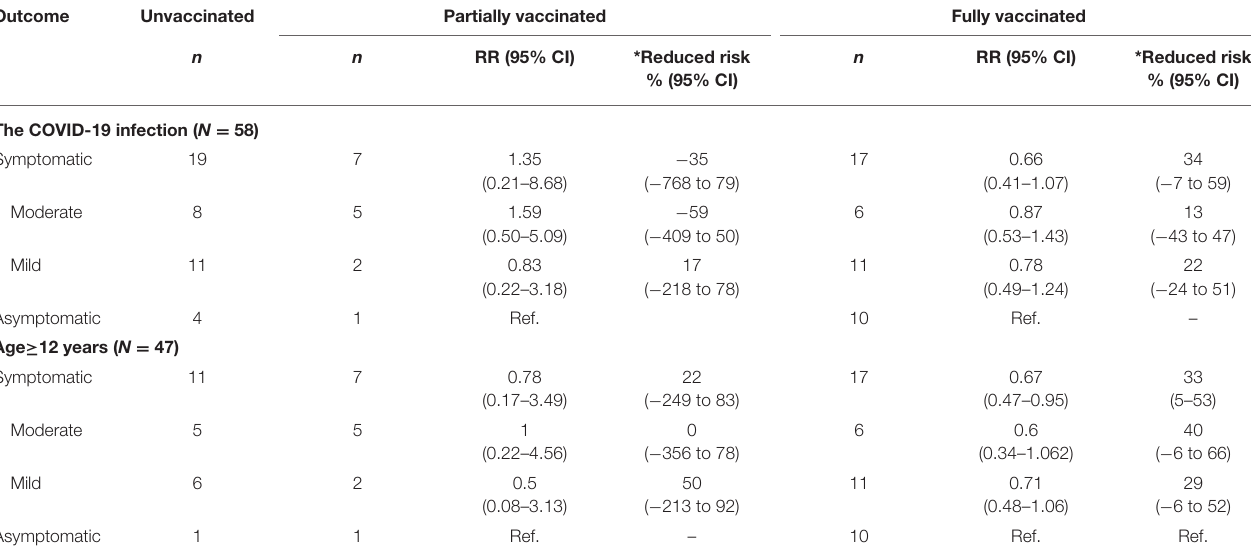
TABLE 5 | Clinical severity of delta variant infected patients in different vaccination status in Jingmen City, Hubei Province in August 2021. Outcome Unvaccinated Partially vaccinated Fully